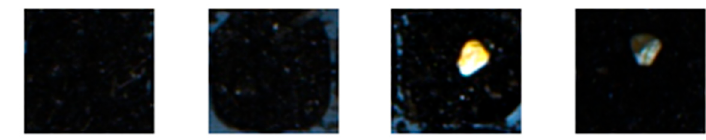
Figure 4. Photos captured after segmentation.